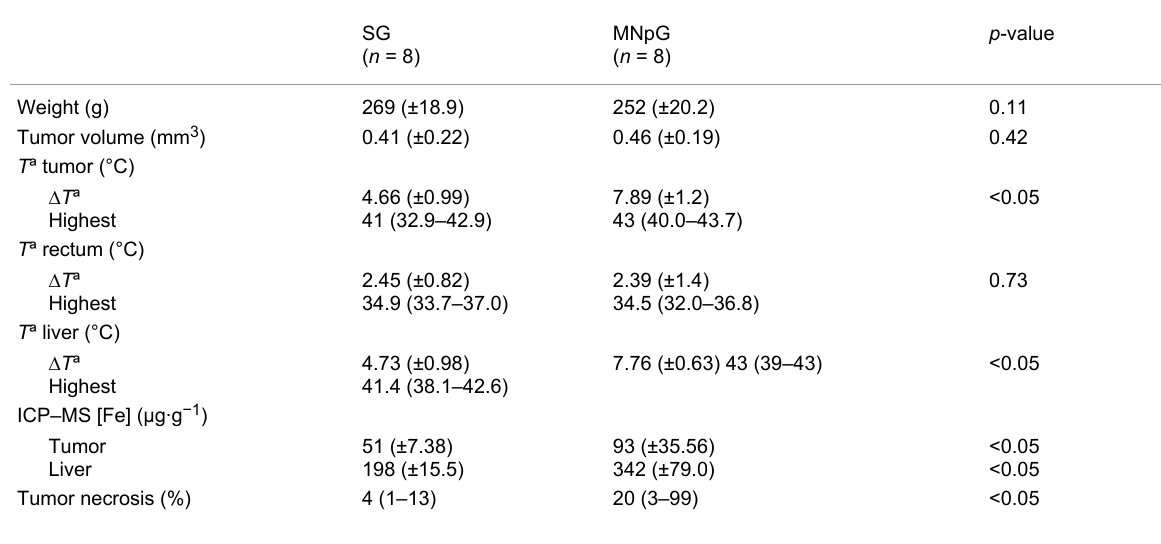
Table 1: Results of the measurements in the two groups of rats. SG: Control group, eight rats infused with saline. MNpG: group of eight rats infused with MNPs. ∆ T ª: temperature increase quantified at the end of the hyperthermia induction cycle. Tumour necrosis (%): percentage of tumor necrosis established by pathologic analysis. The values are expressed as the mean (±SD) when they are adjusted to a Gaussian distribution or median (range) otherwise.